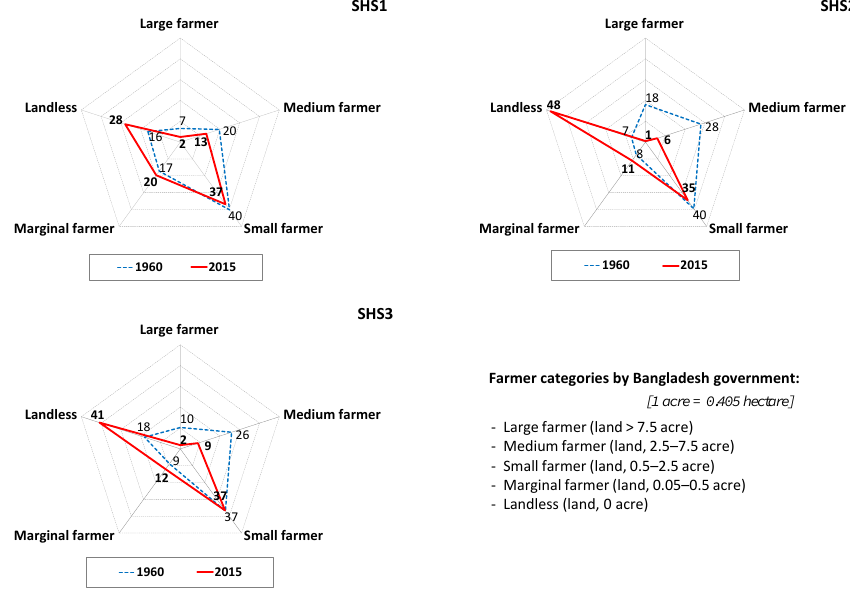
Figure 5. Agricultural land changes with time of the different types of farmer (% of HH respondents).